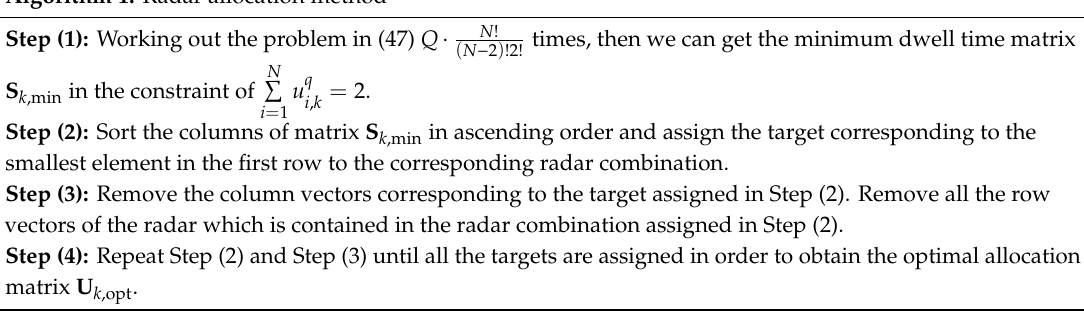
Algorithm 1. Radar allocation